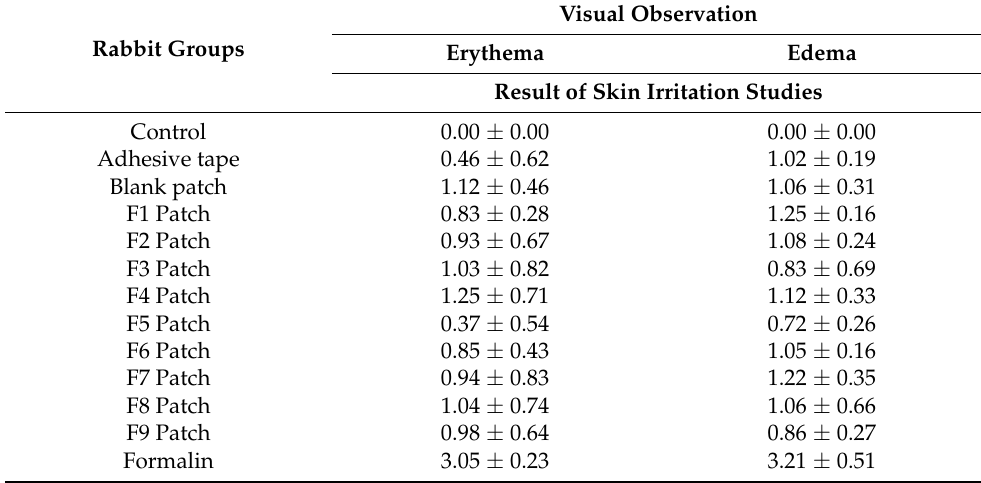
Table 4. Results of skin irritation on rabbits. Data were expressed as mean ± SD, n = 3. Significant compared to formalin ( p < 0.05).